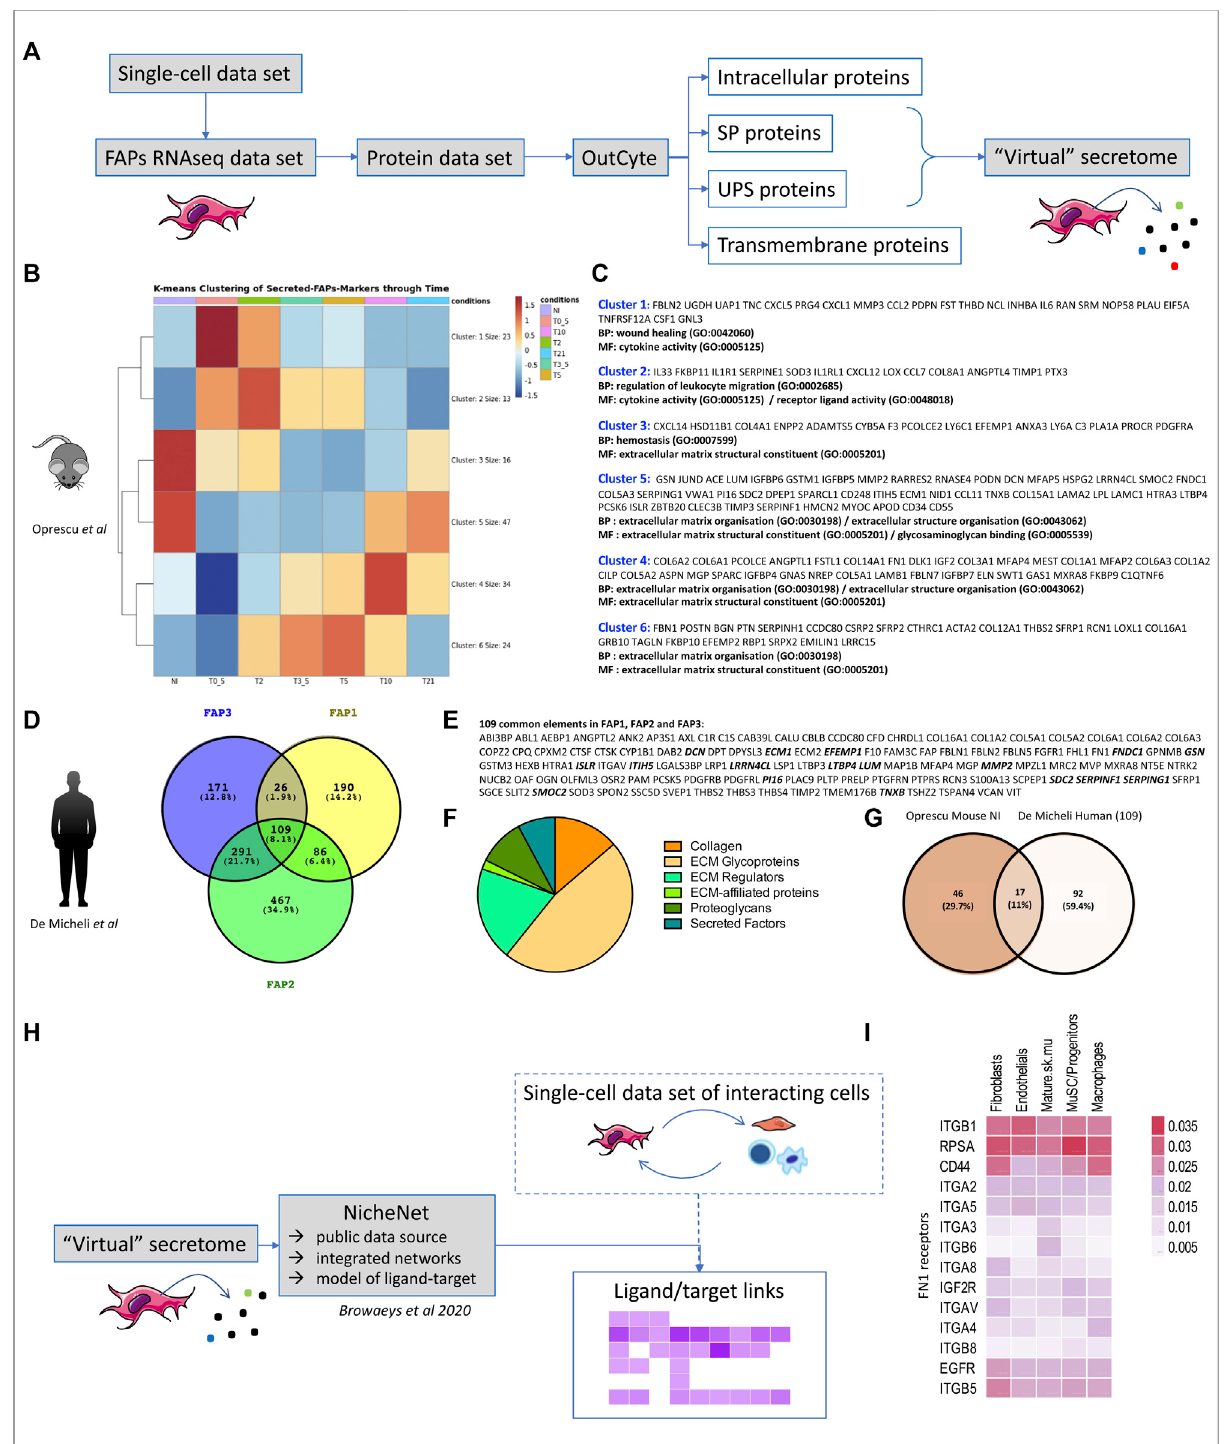
FIGURE 1 Virtual secretome of murine and human FAPs (A) Work fl ow of the study from sc-RNA-seq datasets to virtual secretome. FAPs RNAseq data-set is an expression matrix that consists of FAPs cells barcodes, as given in each study, in columns and FAPs-markers gene-names in rows. SP = signal- peptide, UPS = unconventional peptide sequence. (B) Heatmap of k-means Clustering (with k = 6, produced with pheatmap () function in R) of the genes that are identi fi edas FAPs markers and labelled as secreted (SP,UPS) from thevirtual-secretome-tool “ Outcyte ” . The mean expression of FAPs cells was calculated for each time point per gene. Color values = z-score of expression values. Conditions = NI: non-injured, T0_5 = 0.5 days, T2 = 2 days, T3_5 = 3.5 days, T5 = 5 days, T10 = 10 days, T21 = 21 days after injury. (C) Gene names included in each cluster of the heatmap in (B) , along with the top-2 Gene Ontology Terms, as given by clusterPro fi ler package with function “ enrichGO () ” and parameters: pvalueCutoff = 0.1,